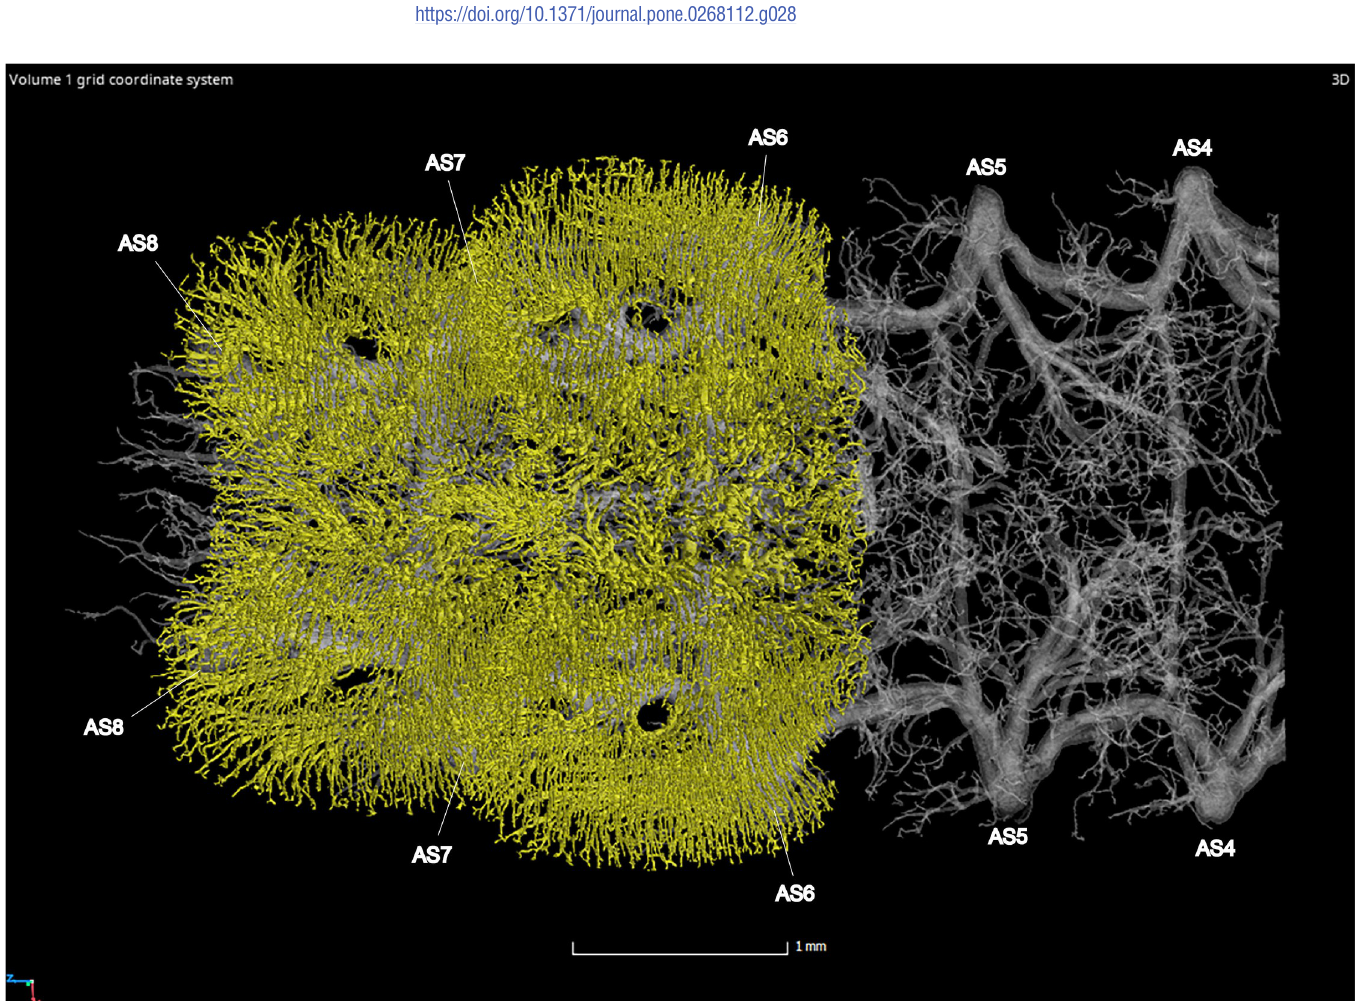
Fig 29. Ventral view of the adult male Photinus pyralis tracheal system with the tracheal brush highlighted in yellow (restricted to abdominal segments VI and VII).